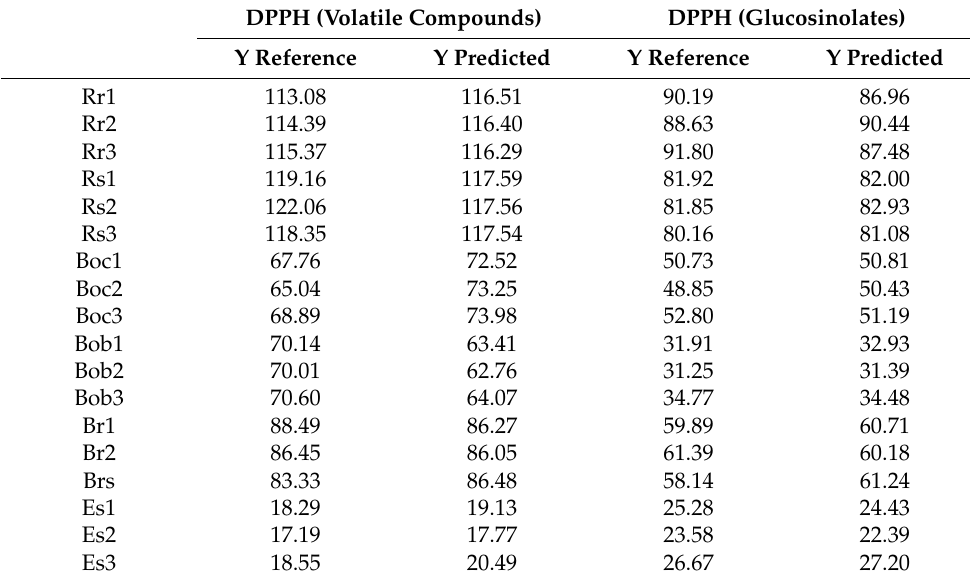
Table 6. Results of calibration and predictive ability of the PLS